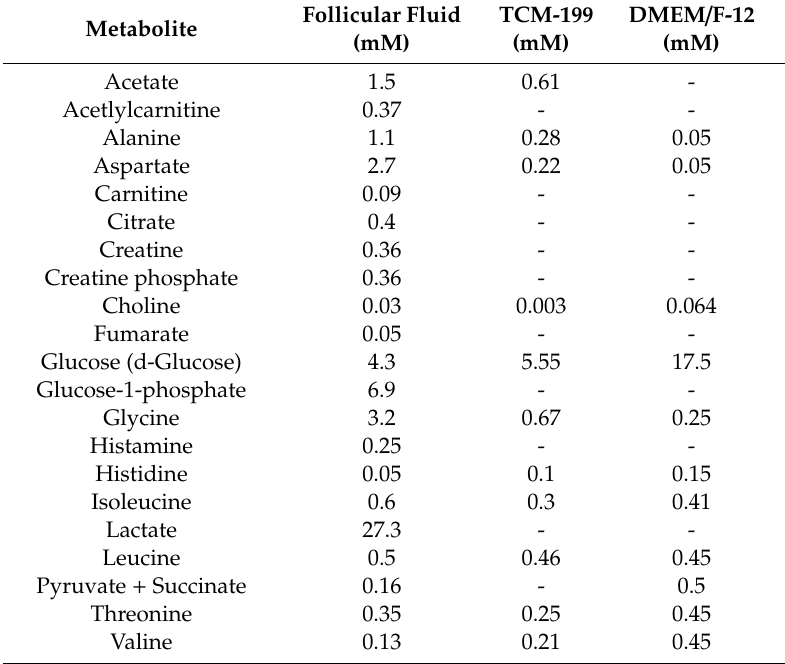
Table 3. Presence and concentration of the metabolites found in equine preovulatory follicular fluid, and in TCM-199 and DMEM / F-12 media (manufacturer’s